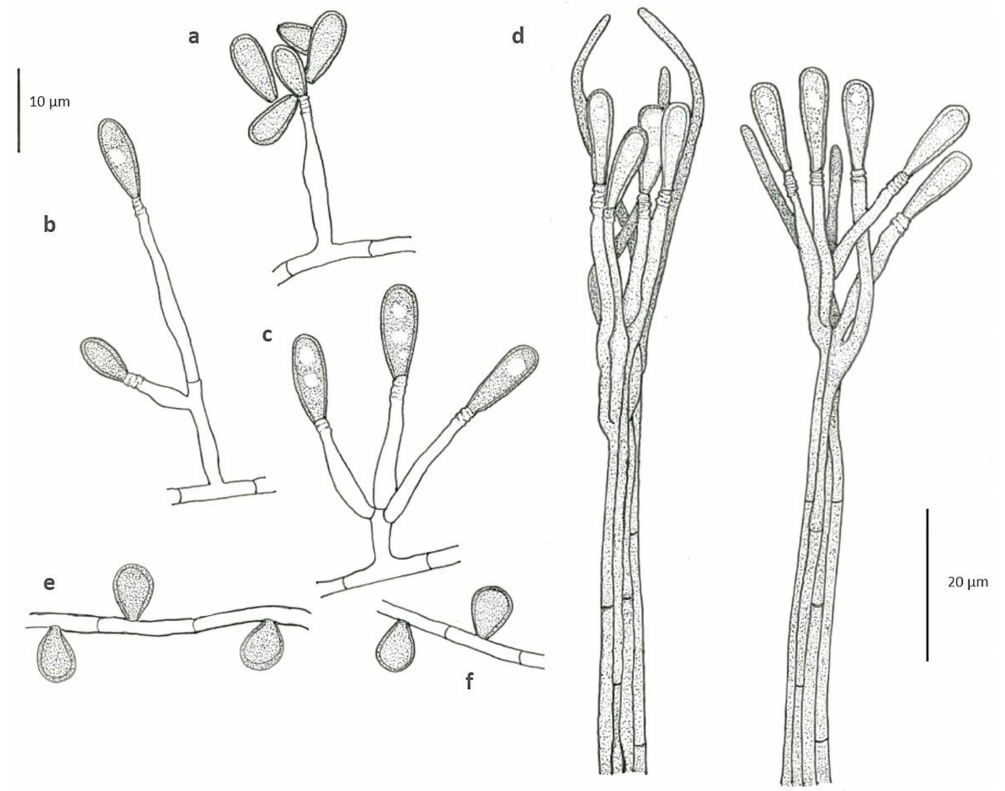
Figure 5. Scedosporium americanum DMic 165285 T . Conidiogenous cells and conidia ( a – c ). Synnematous conidiomata. ( d ). Sessile conidia ( e , f ).